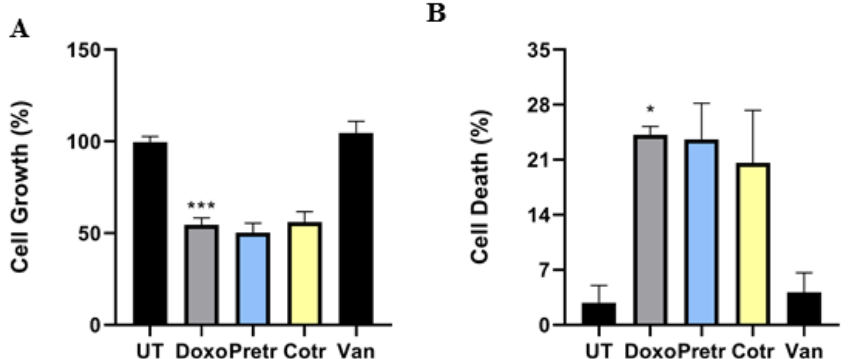
Figure 7. Effect of vanillin on doxo-induced antineoplastic properties in U2OS osteosarcoma cells. Number of living ( A ) and dead ( B ) U2OS cells exposed to 20- µ M doxo for 24 h, pretreated (Pretr) and cotreated (Cotr) with 100- µ M vanillin. UT—untreated cells; doxo—cells exposed to 20- µ M doxo; Van—cells exposed to 100- µ M Van; * p < 0.05; *** p < 0.001 by one-way ANOVA.